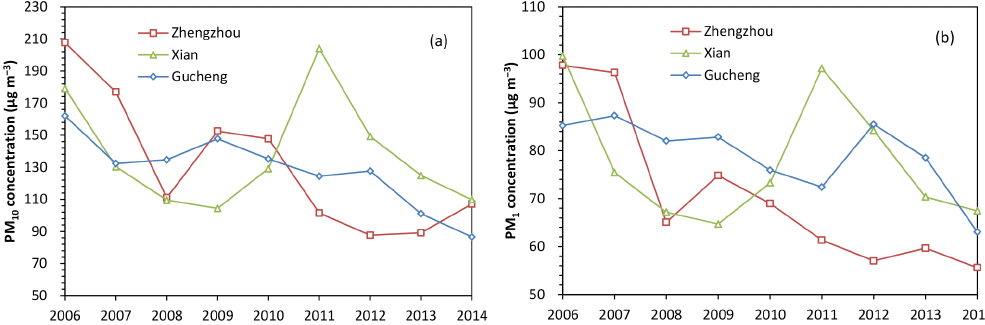
Figure 6. Interannual variation of (a) PM 10 concentration and (b) PM 1 concentration at Zhengzhou, Xian and